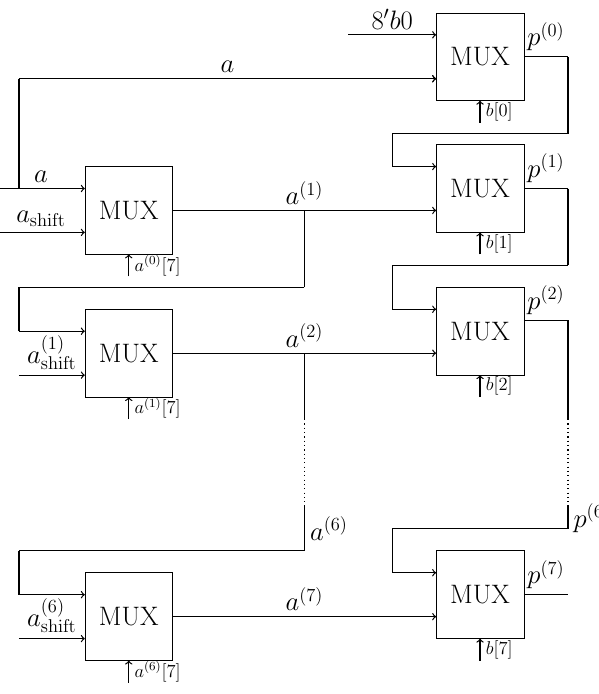
Figure 1. Block diagram of the multiplier: Two 8-bit operands a and b are multiplied by the Russian Peasant Multiplication algorithm [94] in the Galois field (GF ( 2 8 ) ) to obtain the product ( p ). The seven multiplexers on the left control the shifting of the operand ( a ); the shifting in a given stage ( s ) is controlled by the most significant (7th) bit of operand a after the preceding ( s the bit a ( s − 1 ) [ 7 ] . The eight multiplexers on the right accumulate the outcome of the product (the input “8’b0” denotes eight bits with value zero), with the final product ( p ) provided by p ( 7 )